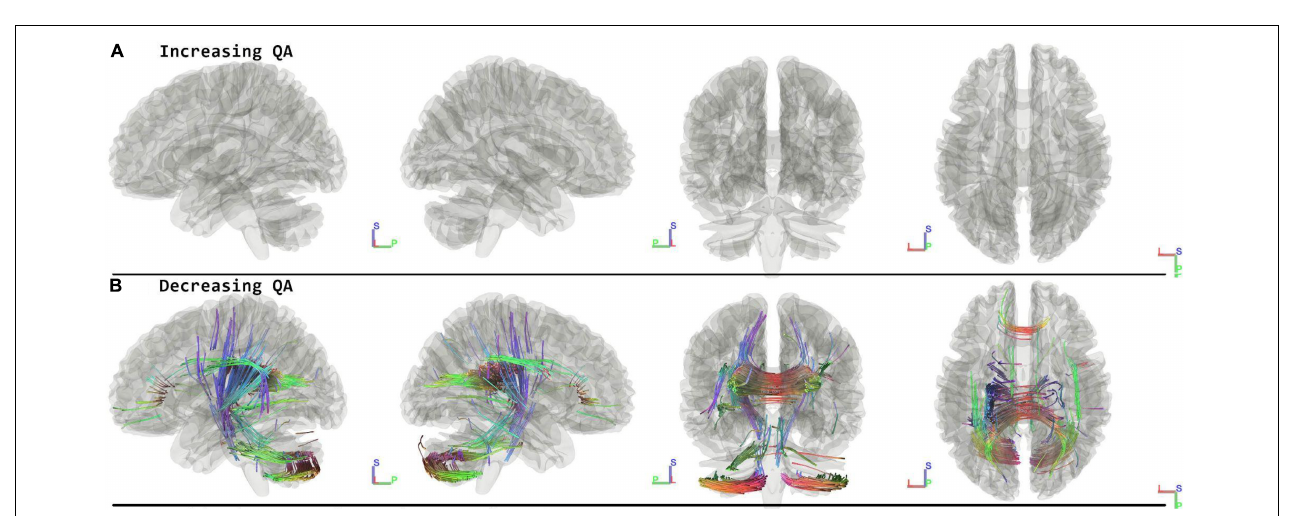
FIGURE 3 | Tracts Associated with changes of followup minus postflight. Increasing QA shows changes in forceps minor, corpus callosum, corticostriatal, and right cingulum (FDR = 0.0567) (A) . Decreasing QA shows changes in the forceps major, corpus callosum, and parietal lobe (FDR = 0.0014) (B) . Blue indicates superior – inferior. Green indicates anterior – posterior. Red indicates left – right.